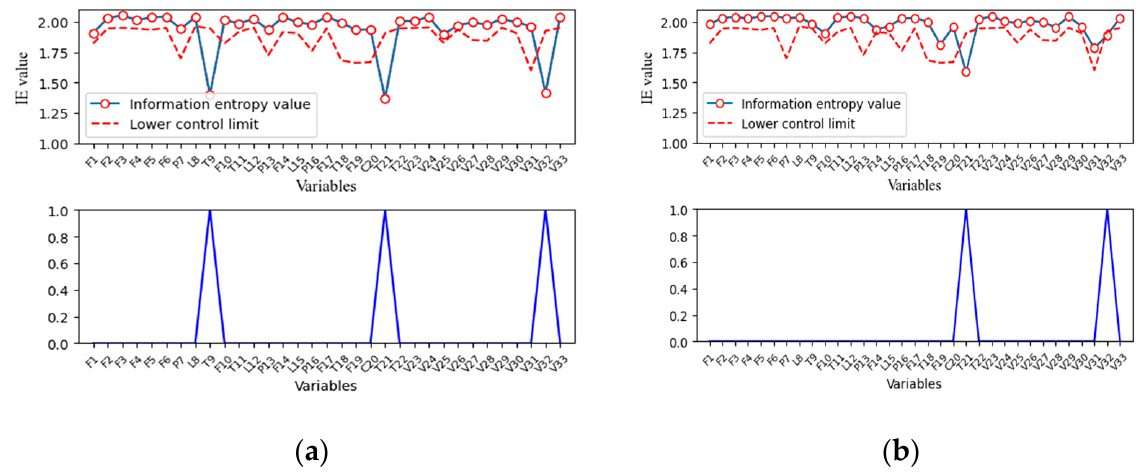
Figure 12. ( a ) IE value of each variable in fault 14; ( b ) IE value of each variable in fault 17.